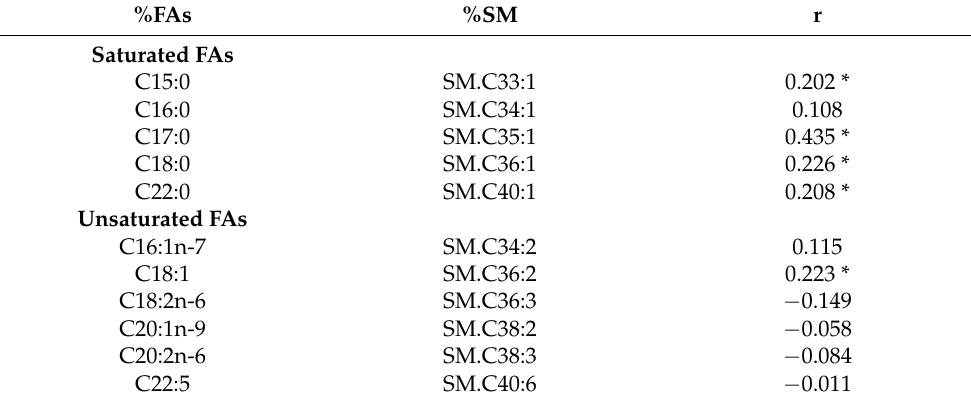
Table 4. Pearson’s correlation coefficients of %FAs and %SM of total PLs ( n = 664). %FAs %SM